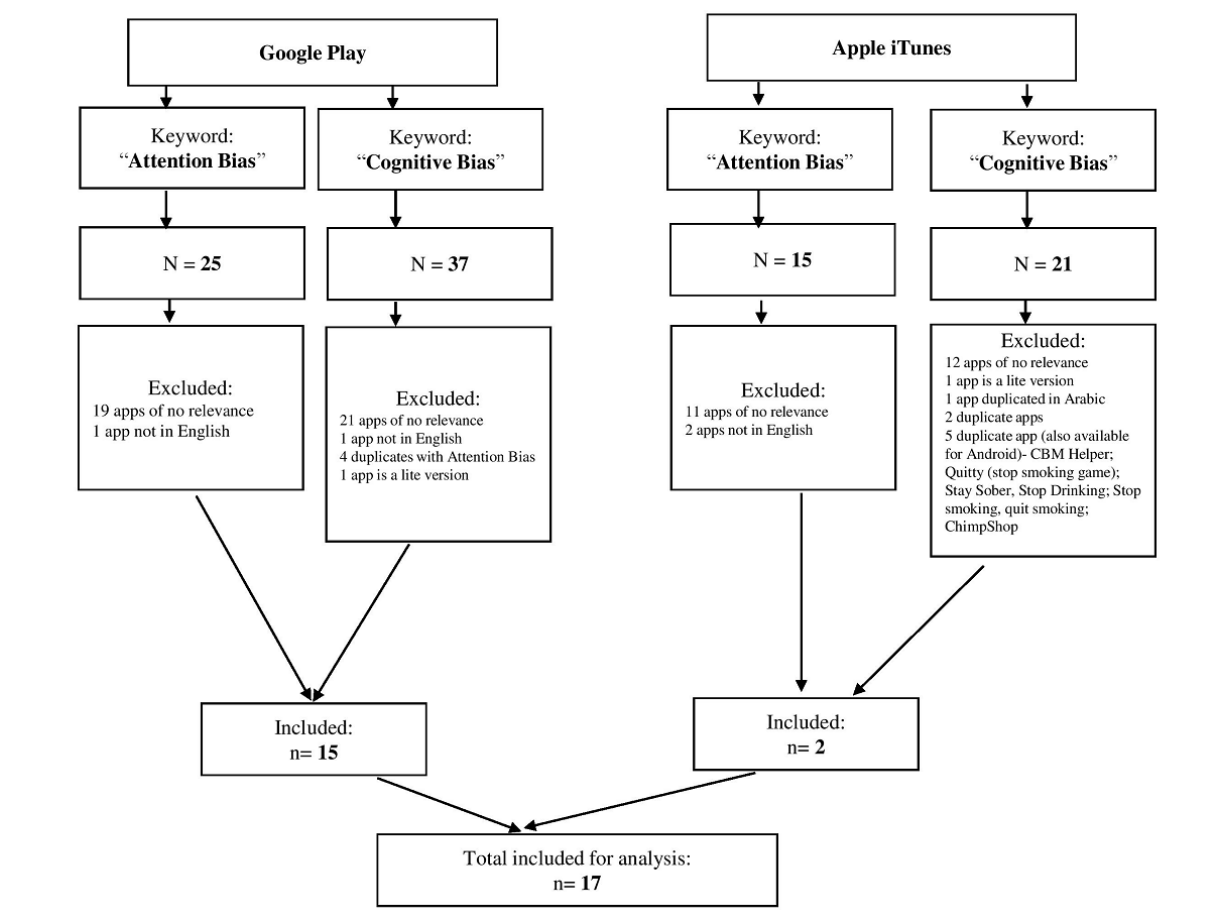
Figure 2. Flowchart of the selection of apps from the commercial stores.